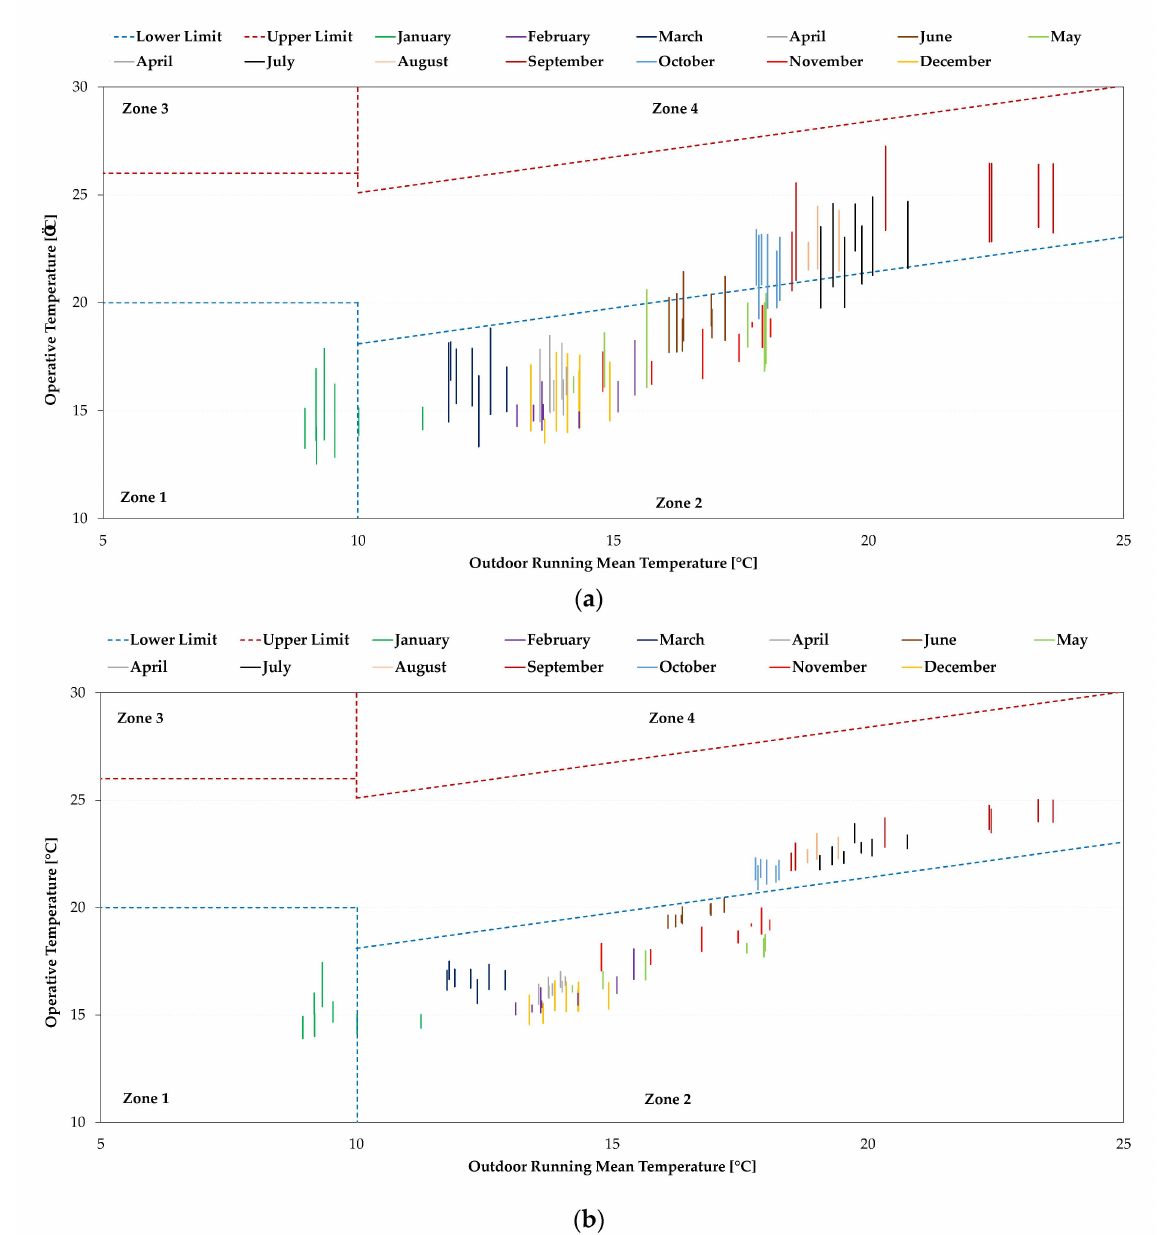
Figure 10. Indoor thermal comfort evaluation according to the adaptive comfort model (EN 16798-1 [41]): ( a ) LSF experi- mental test cell; ( b ) HBM experimental test